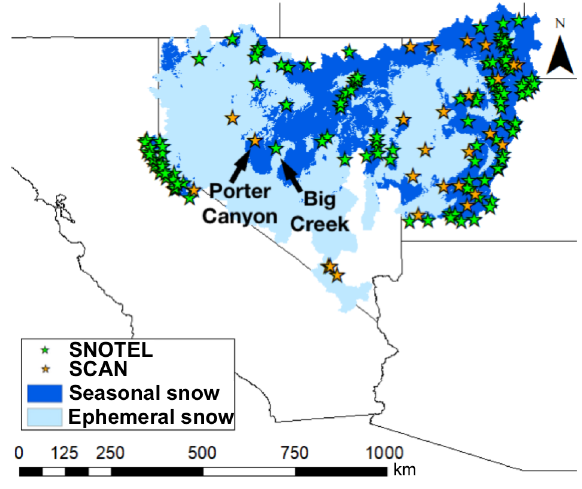
Figure 1. Locations of SNOTEL and SCAN stations in the Great Basin, USA, in ephemeral and seasonal snow as defined by < 60 or ≥ 60 days of maximum consecutive snow duration,